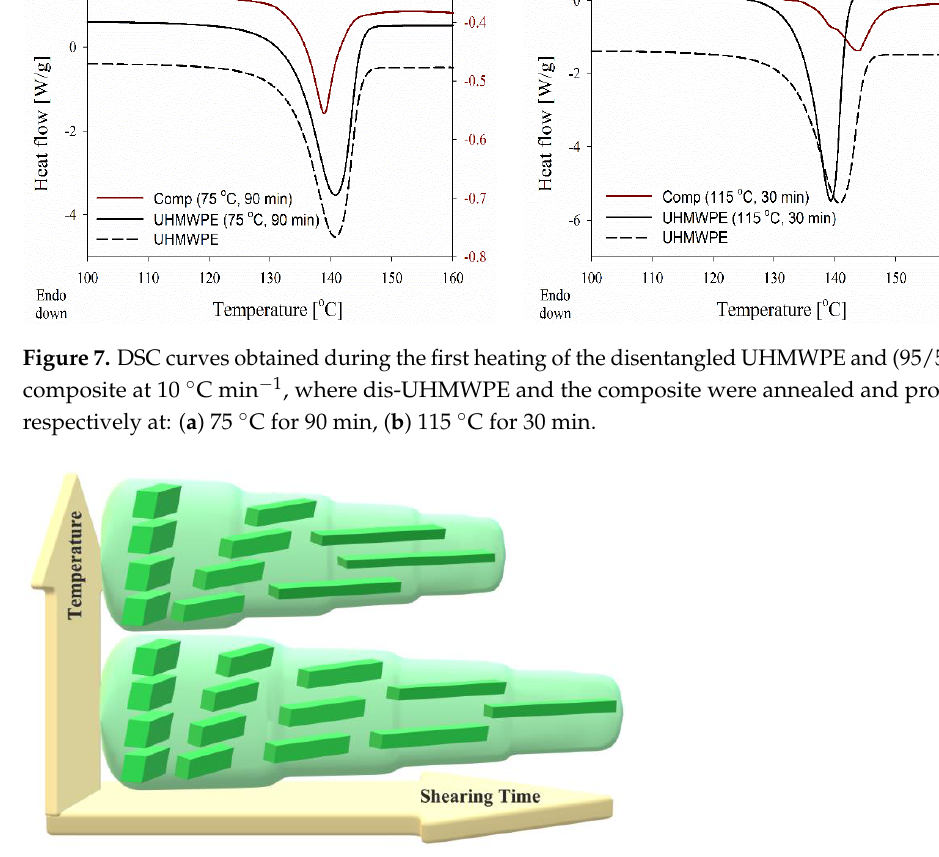
Figure 8. Schematic representation of the stages of dis-UHMWPE crystals during solid-state defor- mation into nanofibers. The crystals undergo crystallographic slip in the direction of macromolecular chains. The resulting fibers become thinner as the shearing time increases and they melt when they become too thin.